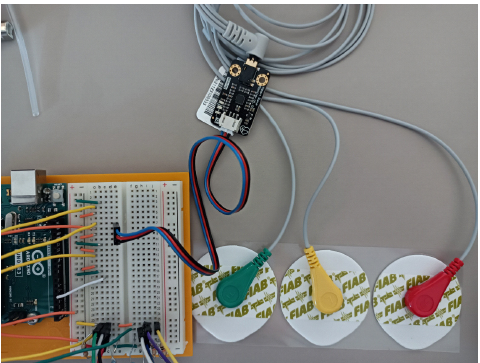
Figure 5. Arduino board with the heartbeat module in blue and 3 electrodes on the right. Equipment: DF ‐ Robot Heart Rate Monitor Sensor SKU SEN0213(DFRobot, Pudong, Shanghai, China).